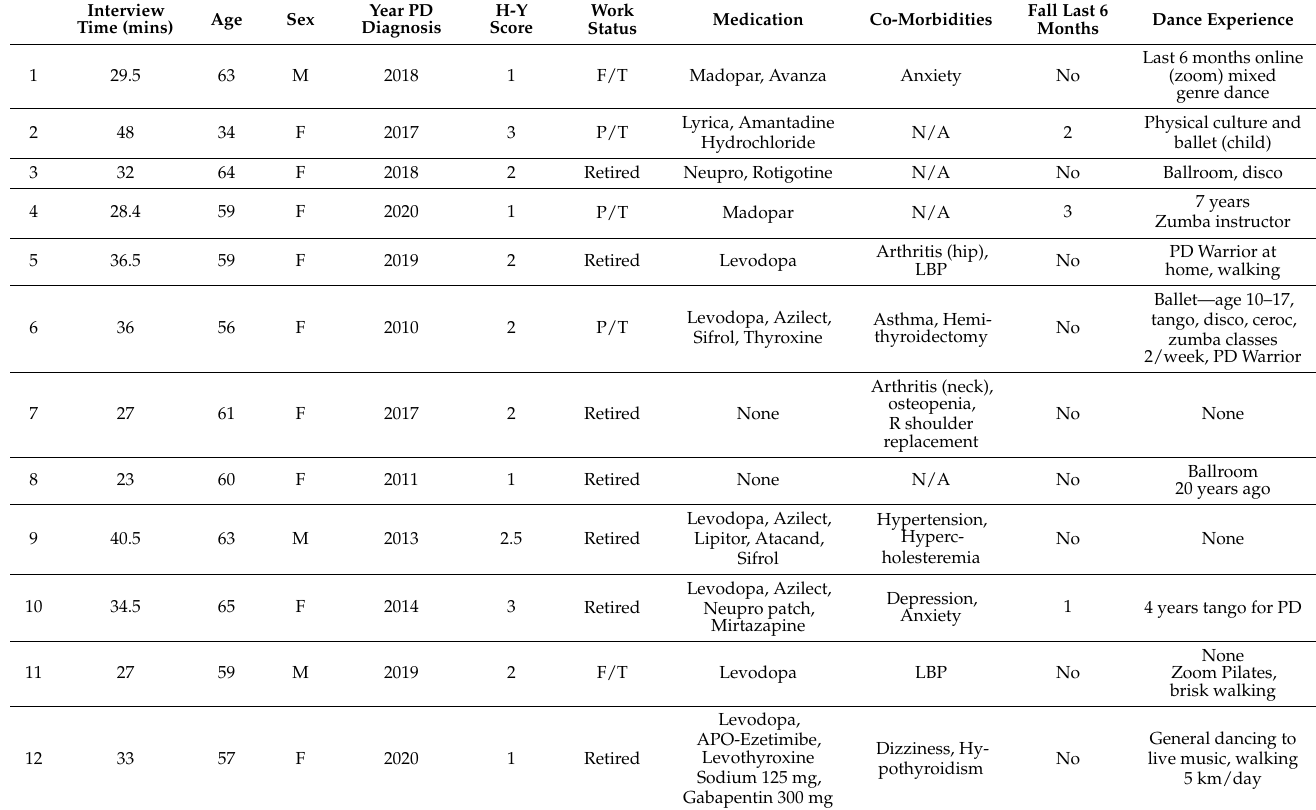
Table 1. Dancer participant demographic